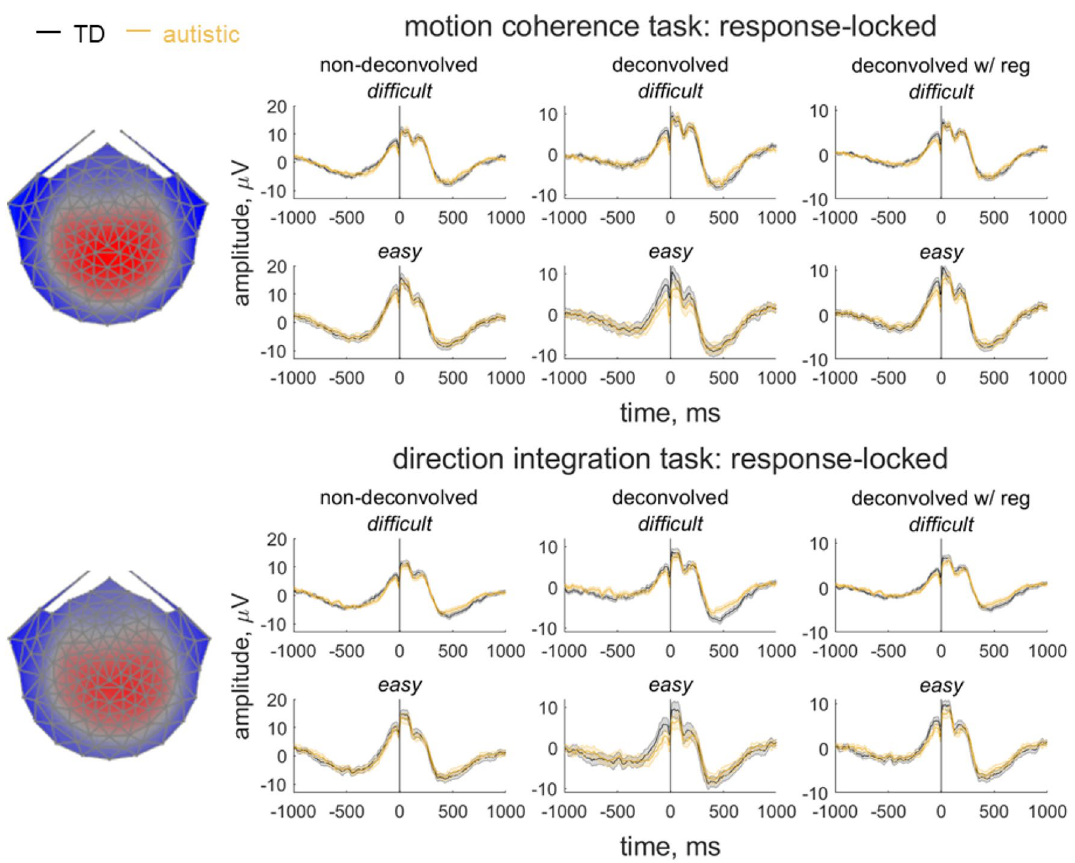
Figure 3. Response-locked evoked potentials for the motion coherence task and direction integration task. Topographic maps represent the forward-model projections of the most reliable component reflecting the weights given to each electrode following reliable components analysis (RCA) on data from all participants pooled across difficulty level for the motion coherence task (top) and direction integration task (bottom). Each individual’s continuous data were multiplied by these weights to provide a component average waveform, with group average response-locked waveforms (± 1SEM) shown for typically developing children (TD; grey) and autistic children (orange) for difficult and easy levels. The left column shows non-deconvolved group average waveforms. The central column shows deconvolved group average waveforms (without regularisation). The right column shows deconvolved group average waveforms with regularisation (ridge